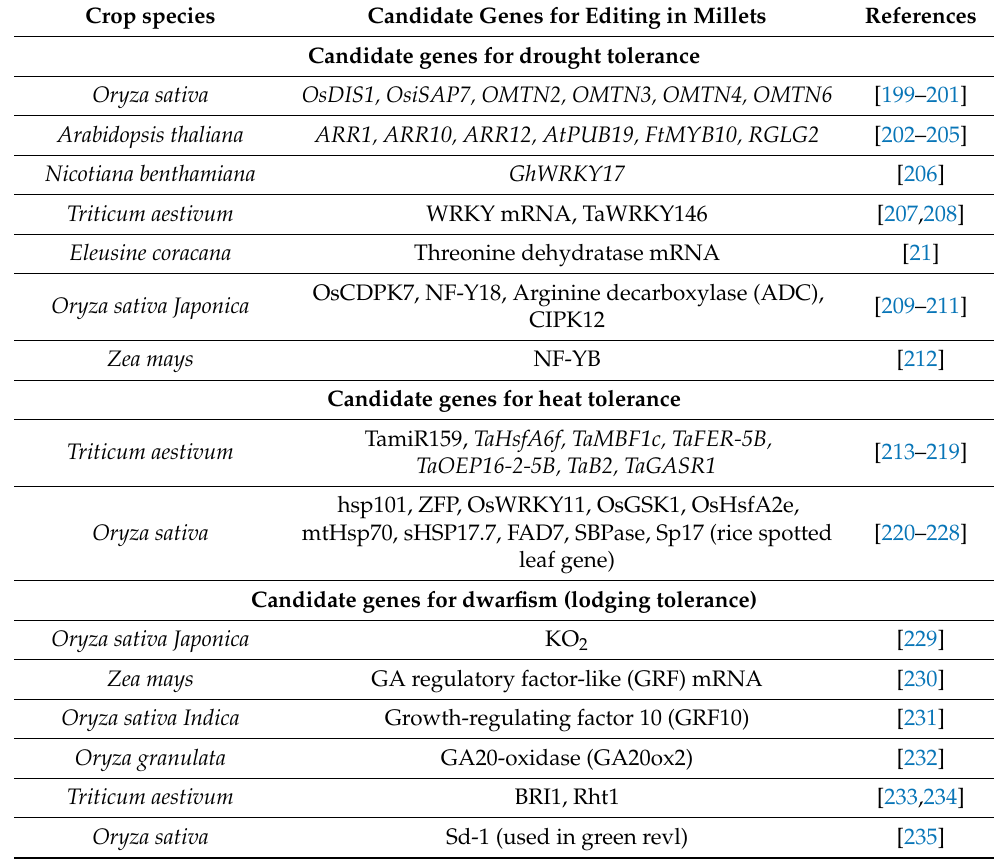
Table 2. List of candidate genes from related species for potential CRISPR/Cas9 editing in